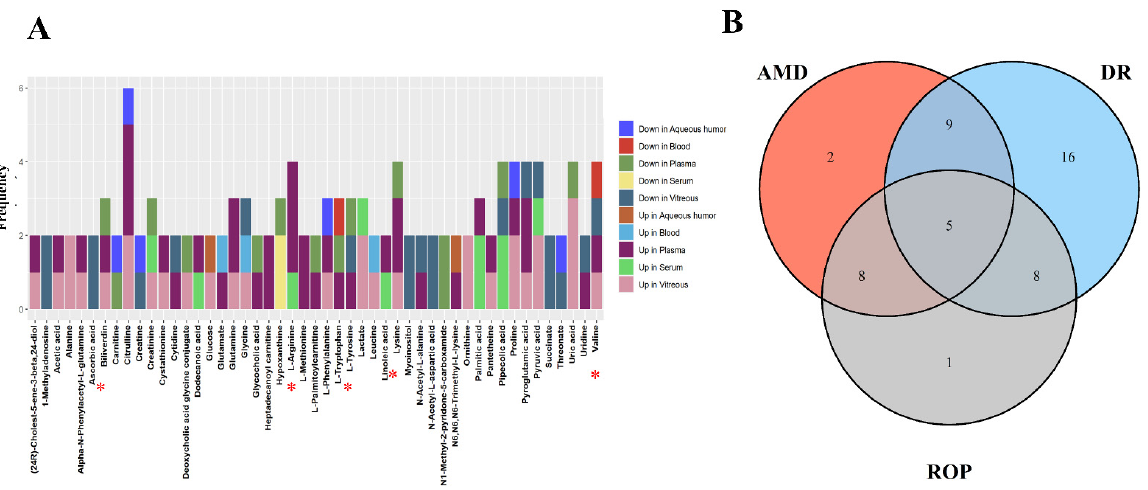
Figure 2. ( A ) horizontal coordinates indicate the metabolites identified repeatedly in the study, vertical coordinates represent the frequency of repeated identification, colors represent the direc- tion of metabolite variation across biological samples, and red asterisks mark the differential me- tabolites found in all three diseases. ( B ) represents the Venn diagram of the metabolites identified repeatedly in the different diseases. * Red asterisks indicate the five differential metabolites identi- fied in three